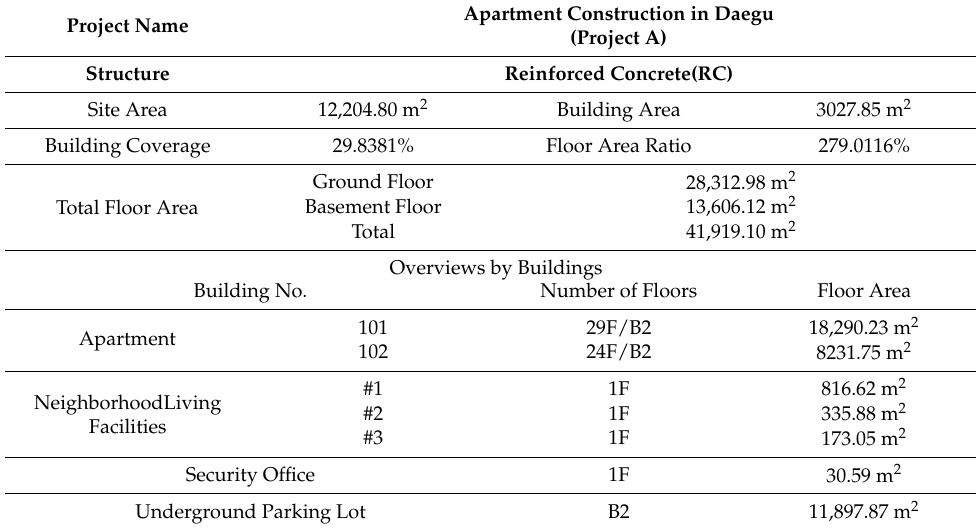
Table A1. Overview of Construction Project A.